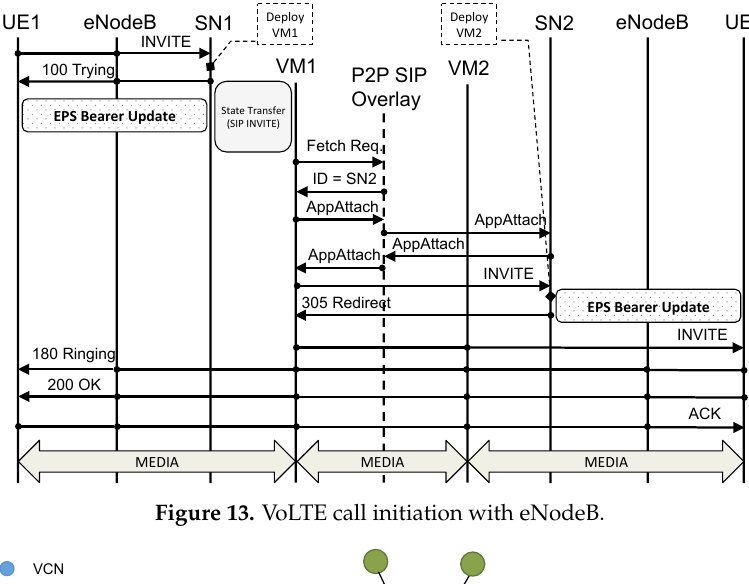
Figure 13. VoLTE call initiation with eNodeB.